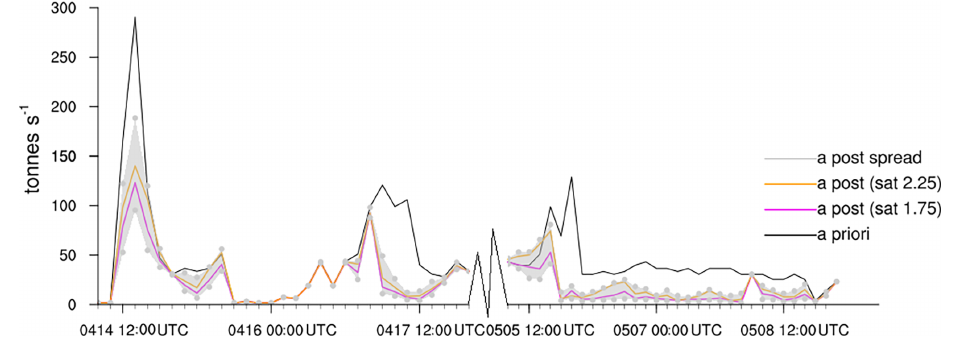
Figure 4. A priori ash emissions and the spread of a posteriori ash emissions calculated by the inversion algorithm using the different uncertainties and satellite data sets during the April and May periods (the break on the x axis indicates the change in time periods). Magenta and orange lines are a posteriori emissions calculated from inversions assuming a priori uncertainty of 75% and satellite uncertainty set at 100%, using a spread in ash distribution of 1.75 and 2.25 in the satellite